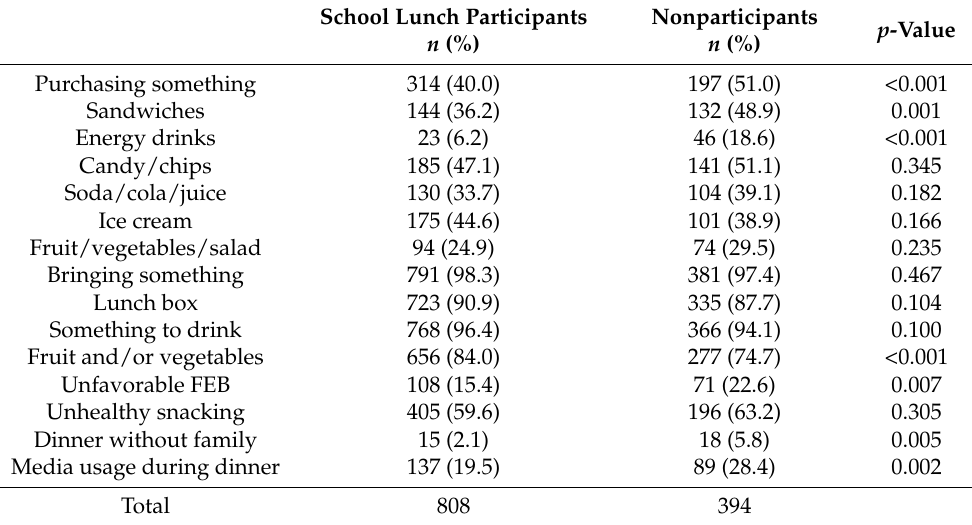
Table 5. Percentage of students by participation status and different behavior. Pearson chi-squared test was used to compare intergroup